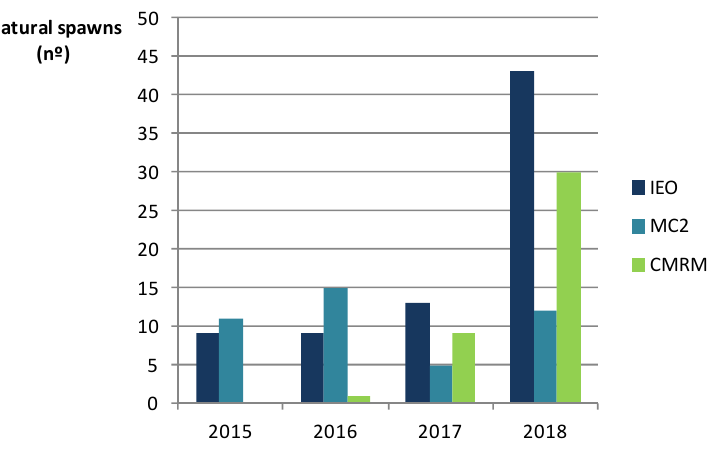
Figure 4 . Total number of natural spawns from the three Galician broodstock (IEO, MC2 and CMRM) during 2015–2018.